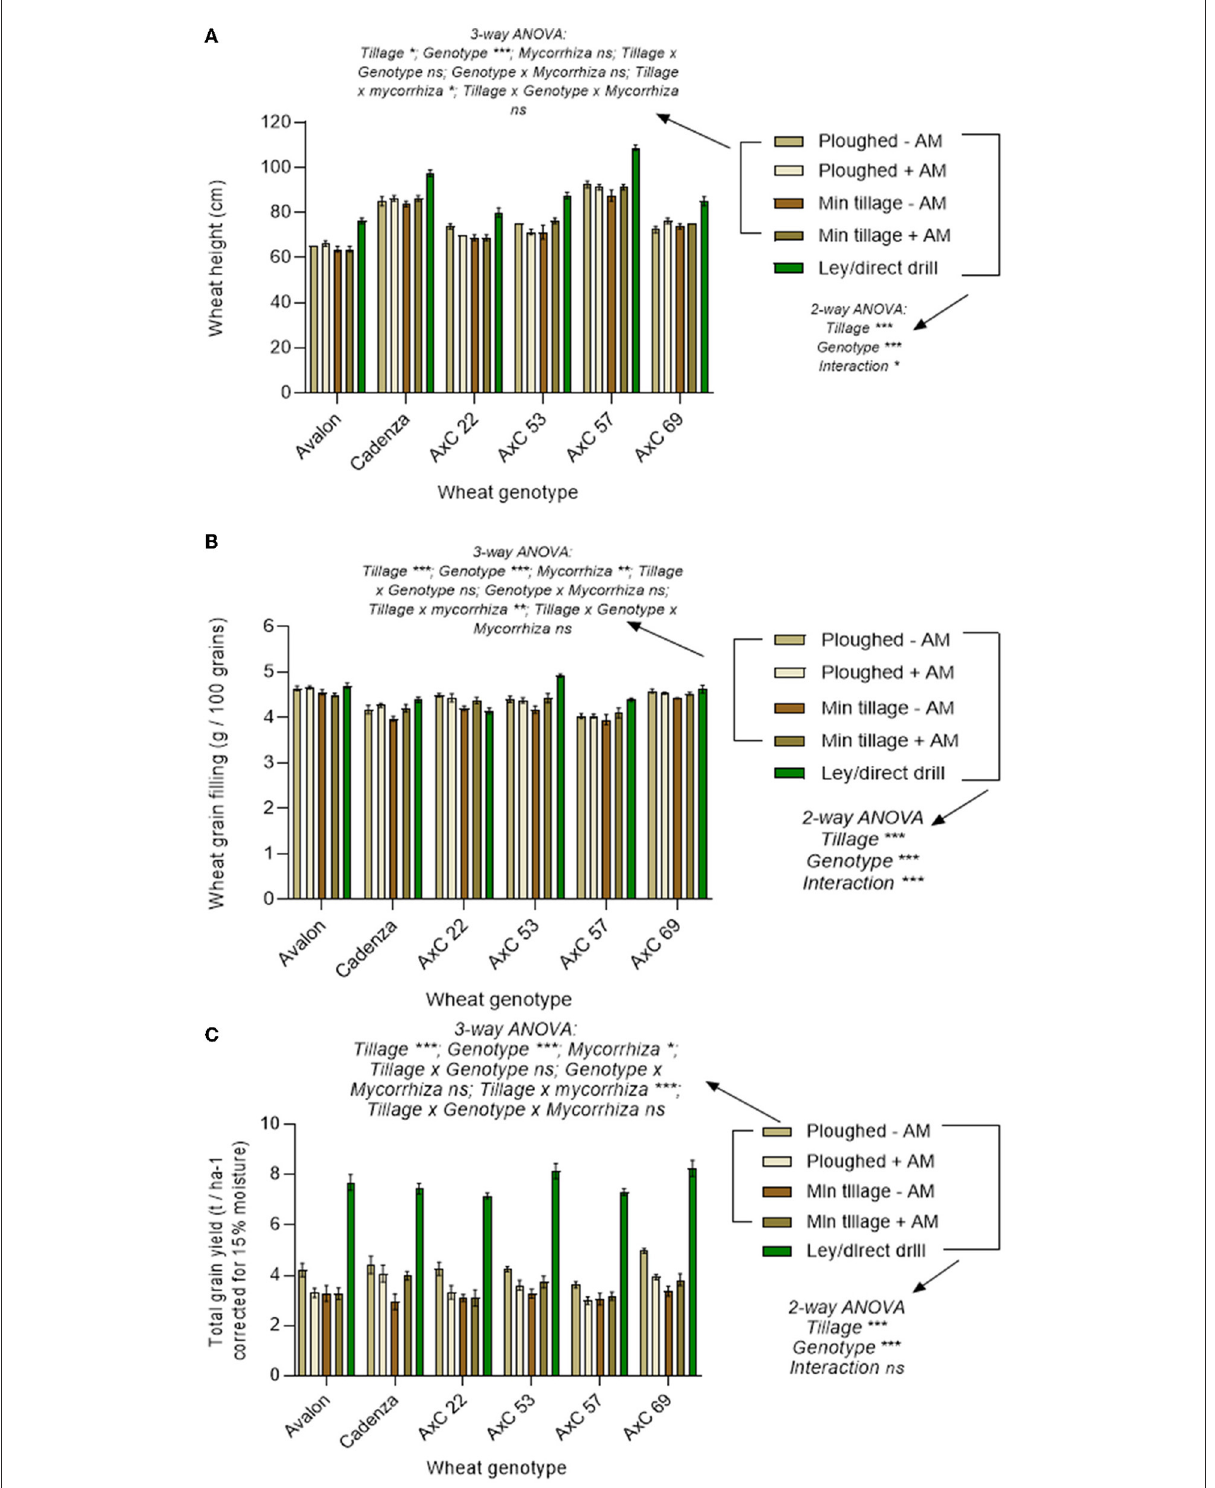
FIGURE8 Cultivation and genotype effects on wheat yields from 2018 harvest. Wheat lines Avalon, Cadenza, AxC22, AxC53, AxC57, and AxC69 in ploughed and disc-cultivated plots with a sterile carrier (- AM) or mycorrhizal inoculum ( + AM) or direct drilled into ley. (A) wheat height (cm) ( n = 20 for each wheat genotype), (B) grain weight (g / 100 grains) ( n = 20 for each wheat genotype), and (C) grain yield (15% moisture content correction, t ha − 1 ) ( n = 20 for each wheat genotype). Error bars show ± 1 SE. The results of the three-way ANOVA testing for effects of genotype, mycorrhizal inoculum and tillage (ploughing vs. disc cultivated) and their interactions are presented for the permanent arable plots (excluding the ley). In parallel, the two-way ANOVA results are presented for effects of tillage (direct drilled ley, disc cultivated, and ploughed) and genotype, and their interaction, averaging across the mycorrhizal inoculum treatments, and including the ley plots. In each case, * p = 0.05; ** p = 0.001; and *** p < 0.0001